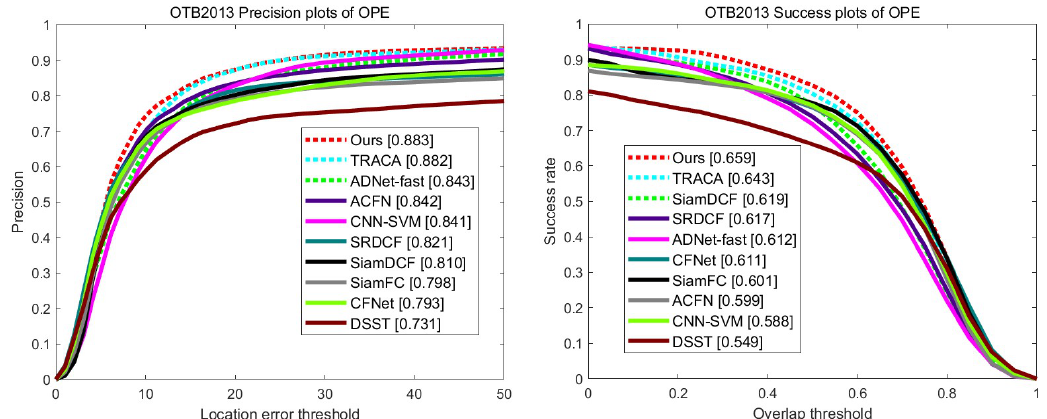
Figure 6. The precision and success plots on the OTB2013 [28] dataset by using one-pass